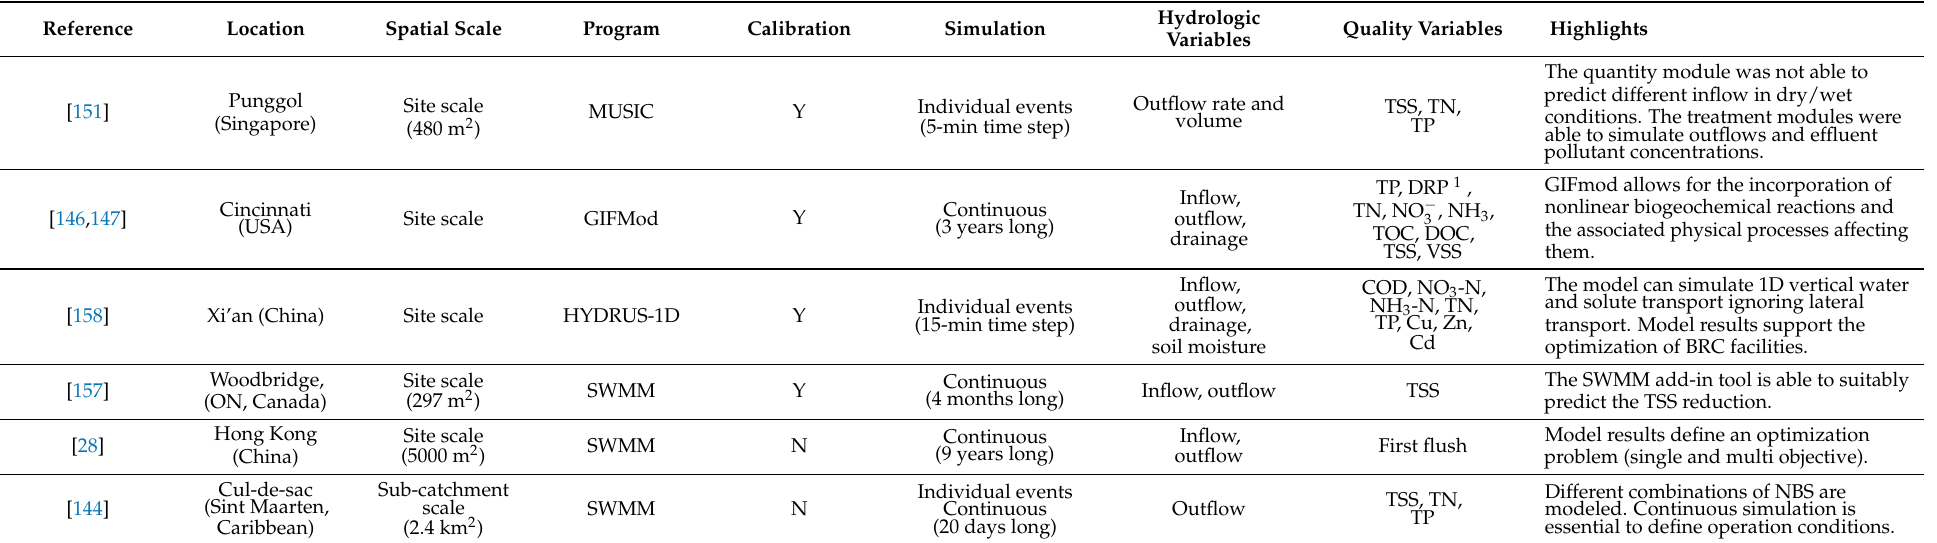
Table 7. Modeling studies of BRCs including quality processes at the subcatchment scale, eventually including model calibration at the site scale for a single BRC installation. For each study, the site characteristics, including the location and spatial scale, are reported together with the modeling features, including the calibration phase, simulation conditions, and modeled